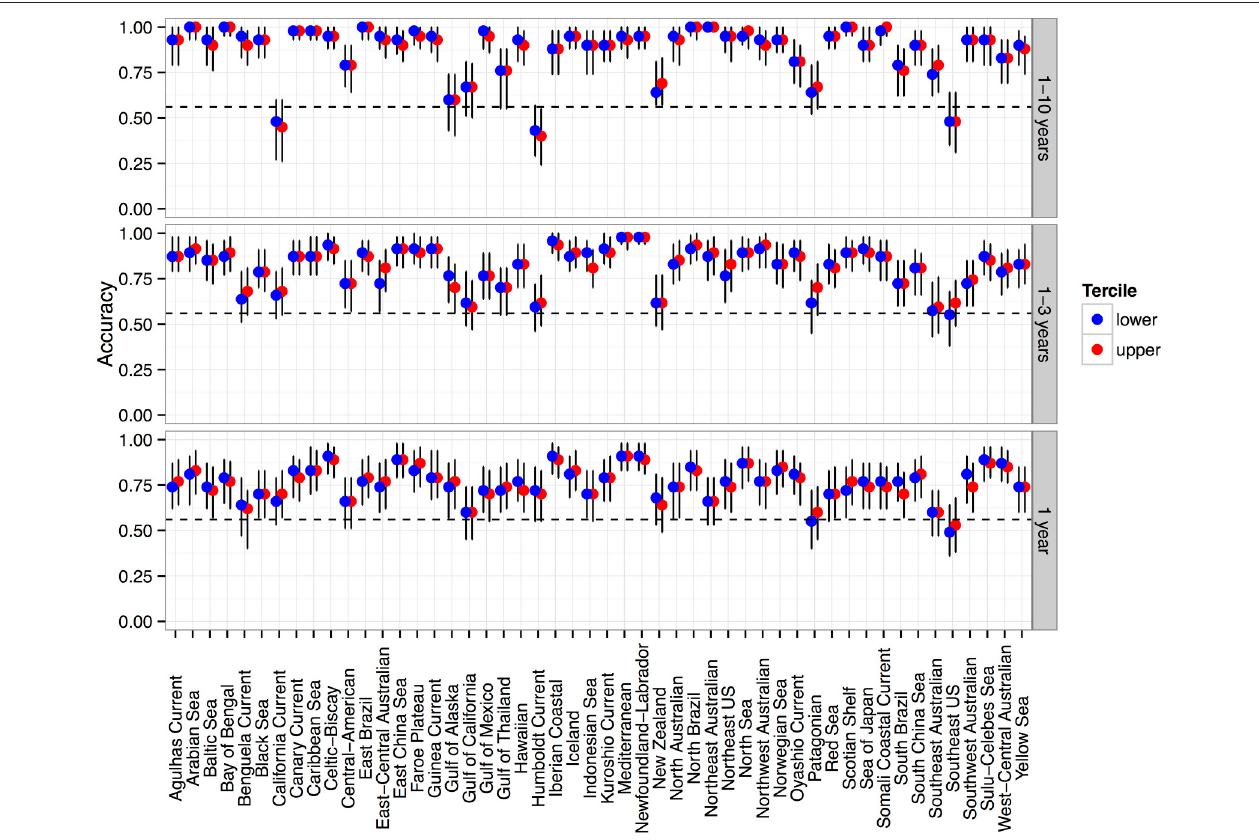
FIGURE 4 | Forecast Accuracy with 95% confidence intervals for each LME for upper and lower SST tercile predictions for a 1 year ahead forecast and over the next 3 and 10 years. Accuracy scores higher than the dotted line are better than chance.